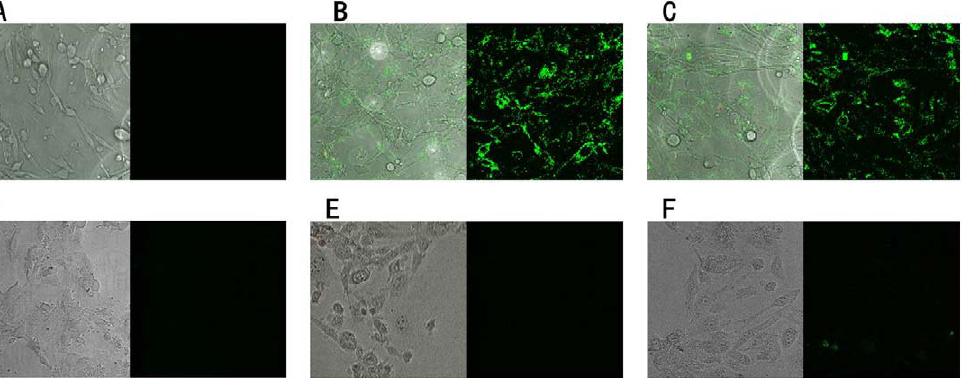
Figure 4. Confocal images of cultured U118-MG and SVGp12 cells staining with FAM-labeled aptamers. Cells were incubated with FAM labeled initial library and aptamers. The initial library showed the background binding and aptamers showed significant binding over the background. For U118-MG cells: A= initial library; B= GBM128; C= GBM131. For SVGp12 cells; D= initial library; E= GBM128; F= GBM131. The final concentration of FAM-labeled aptamers was 250 nM.